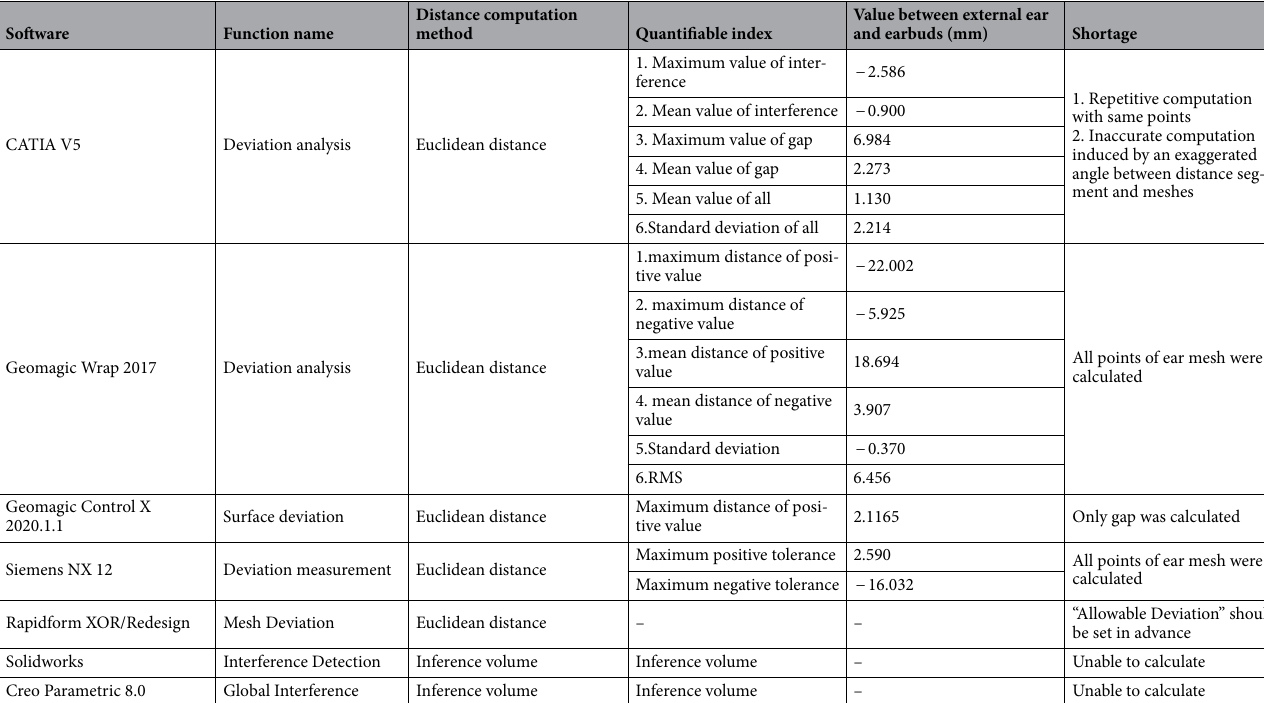
Table 2. Comparison between deviation analysis result of seven commercial CAD software tools on concha and body portion of